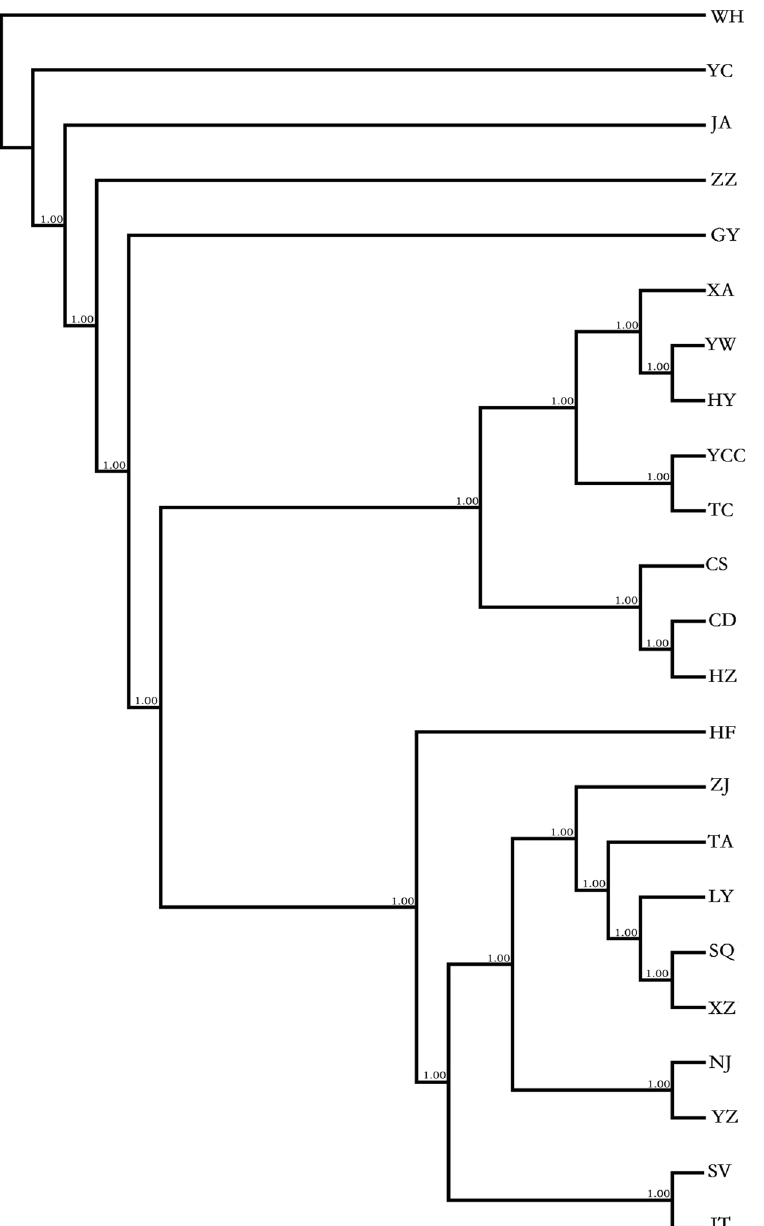
Figure 3. NJ tree inferred from the concatenated mtDNA